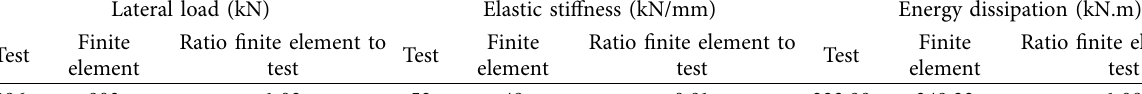
Table 1: Comparison of fnite element analysis results [29] and Choi and Park model test [28].